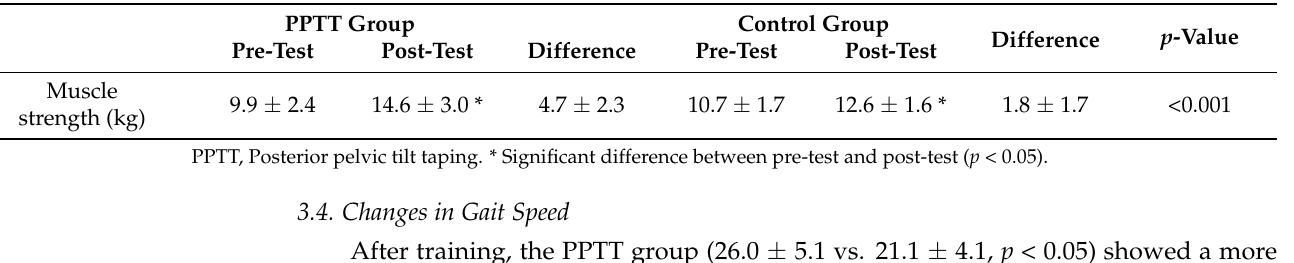
Table 3. Changes in the muscle strength of the study participants (N = 40).